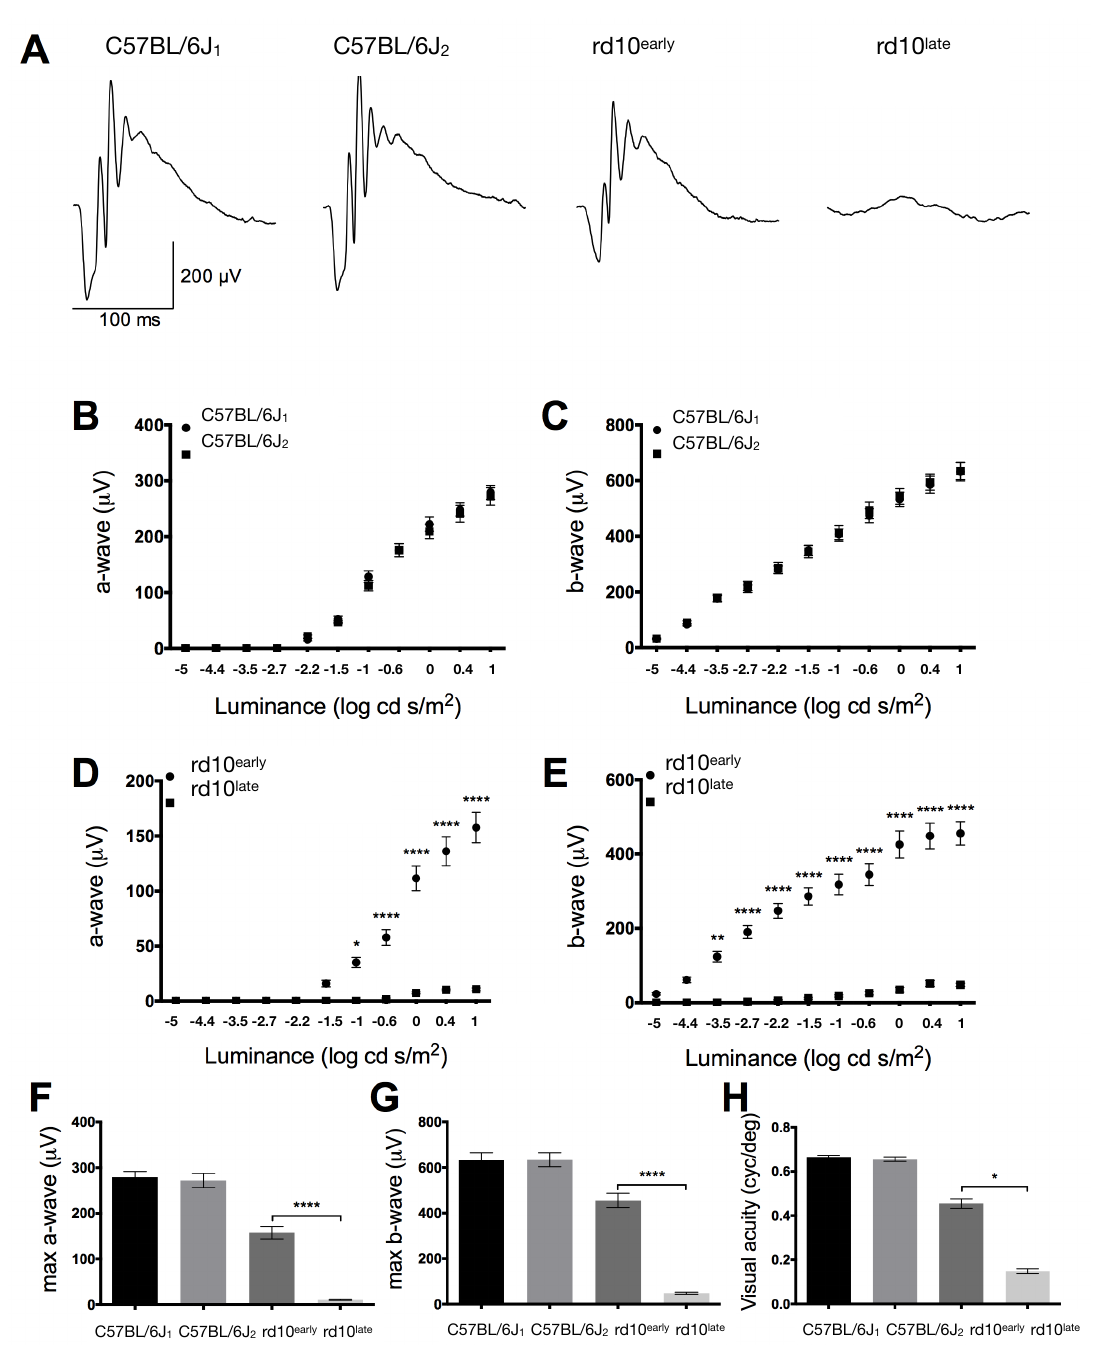
Figure 1. Effect of retinal degeneration on retinal function. ( A ) Representative dark-adapted ERG intensity responses to 1 log cd · s/m 2 flashes in C57BL/6J, rd10early, and rd10late mice. ( B – E ) Luminance–response curves of C57BL/6J ( B , C ) and rd10 ( D , E ) mice ( n = 3), showing measure- ments for a-wave ( B , D ) and b-wave ( C , E ) responses. ( F , G ): Mean values of a-wave ( F ) and b-wave ( G ) in the four groups of mice tested. ( H ): Visual acuity measured as the spatial frequency threshold in C57BL/6J, rd10early, and rd10late mice. Two-tail (ERG) and one-way (optomotor test) ANOVA and Tukey’s post hoc test. * p < 0.05, ** p < 0.01, **** p < 0.0001. C57BL/6J1: postnatal day (P)20; C57BL/6J2: P40; rd10early: P18 and rd10late: